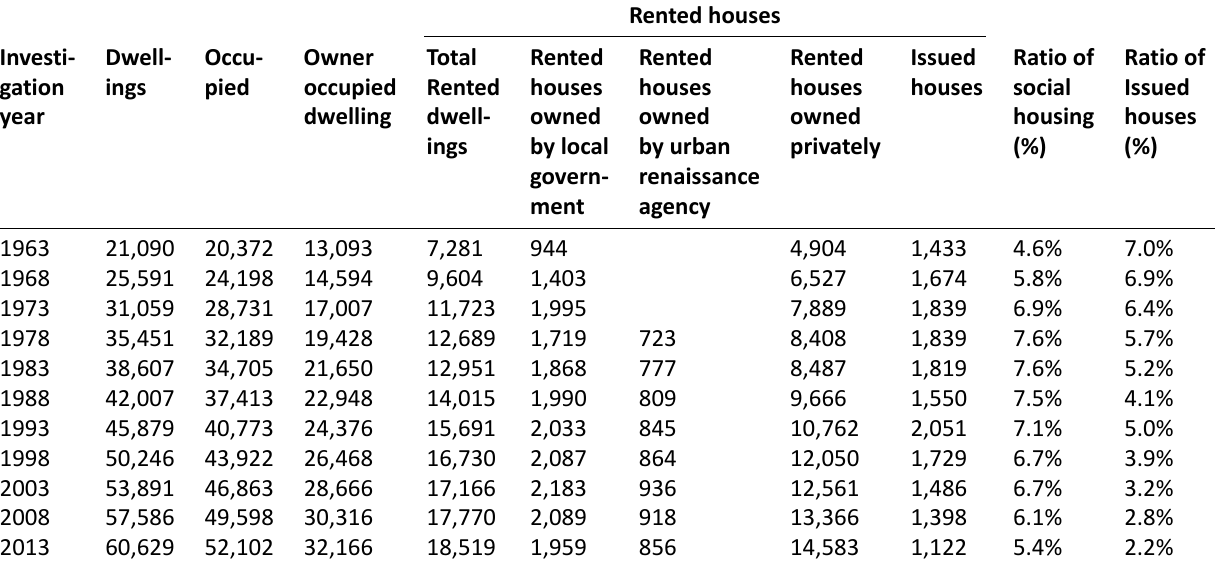
Table 1. Trends of numbers of dwellings by tenure of dwellings.